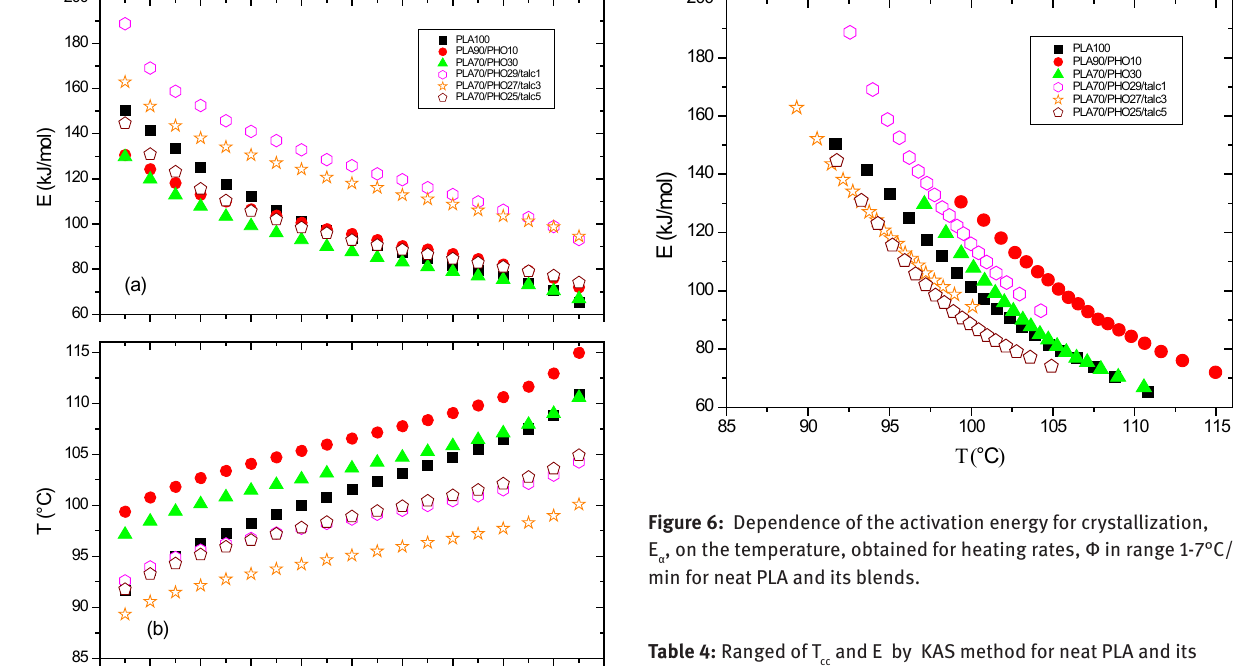
Table 4: Ranged of T